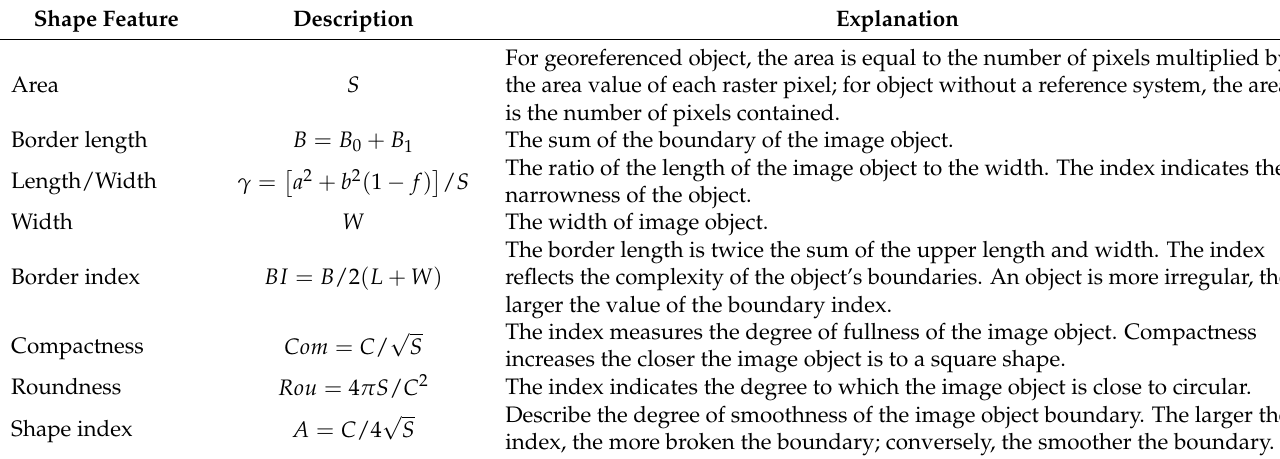
Table 3. An equation and explanation for the shape